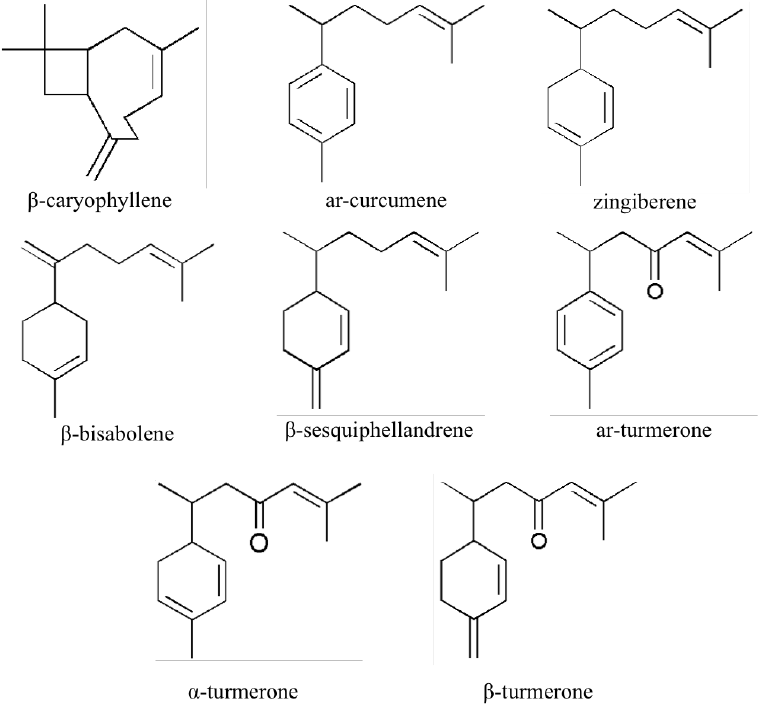
Figure 5. Structures of eight typical volatile compounds in C. longa.